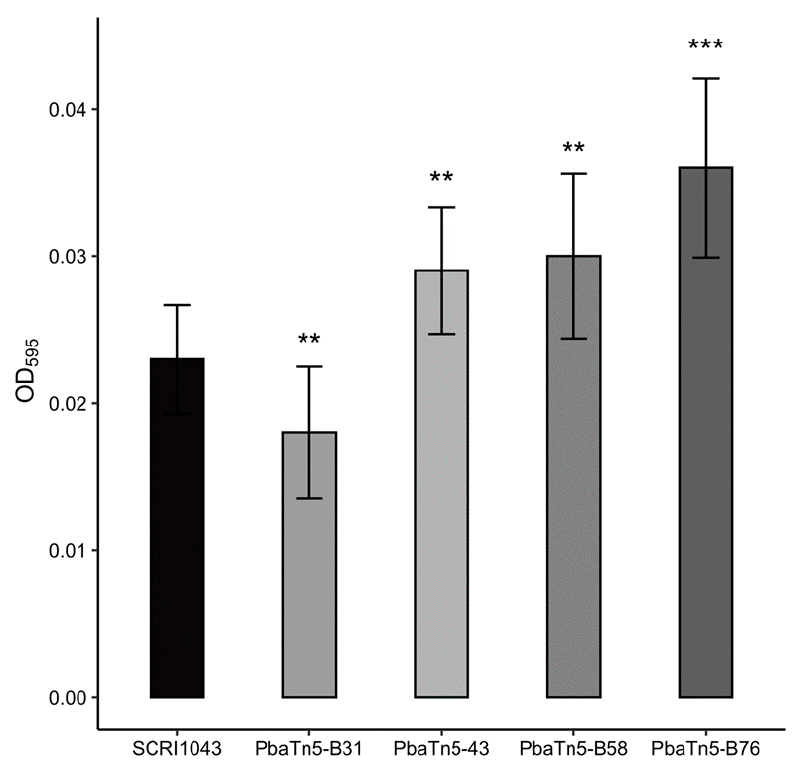
Figure 2. The in vitro biofilm formation ability of P. atrosepticum SCRI1043 wild-type strain and mutant strains differed in M9 minimal media supplemented with 0.4% glycerol. The figure depicted only mutants where the biofilm formation level was significantly different from the wild-type P. atrosepticum SCRI1043. All strains were examined in two independent experiments with duplicate samples, and the error bars indicate standard deviations. Statistically significant differences in biofilm formation between wild-type P. atrosepticum SCRI1043 and mutant strains are indicated (*** p < 0.001; ** p < 0.01) and were determined by the Student’s t -test.